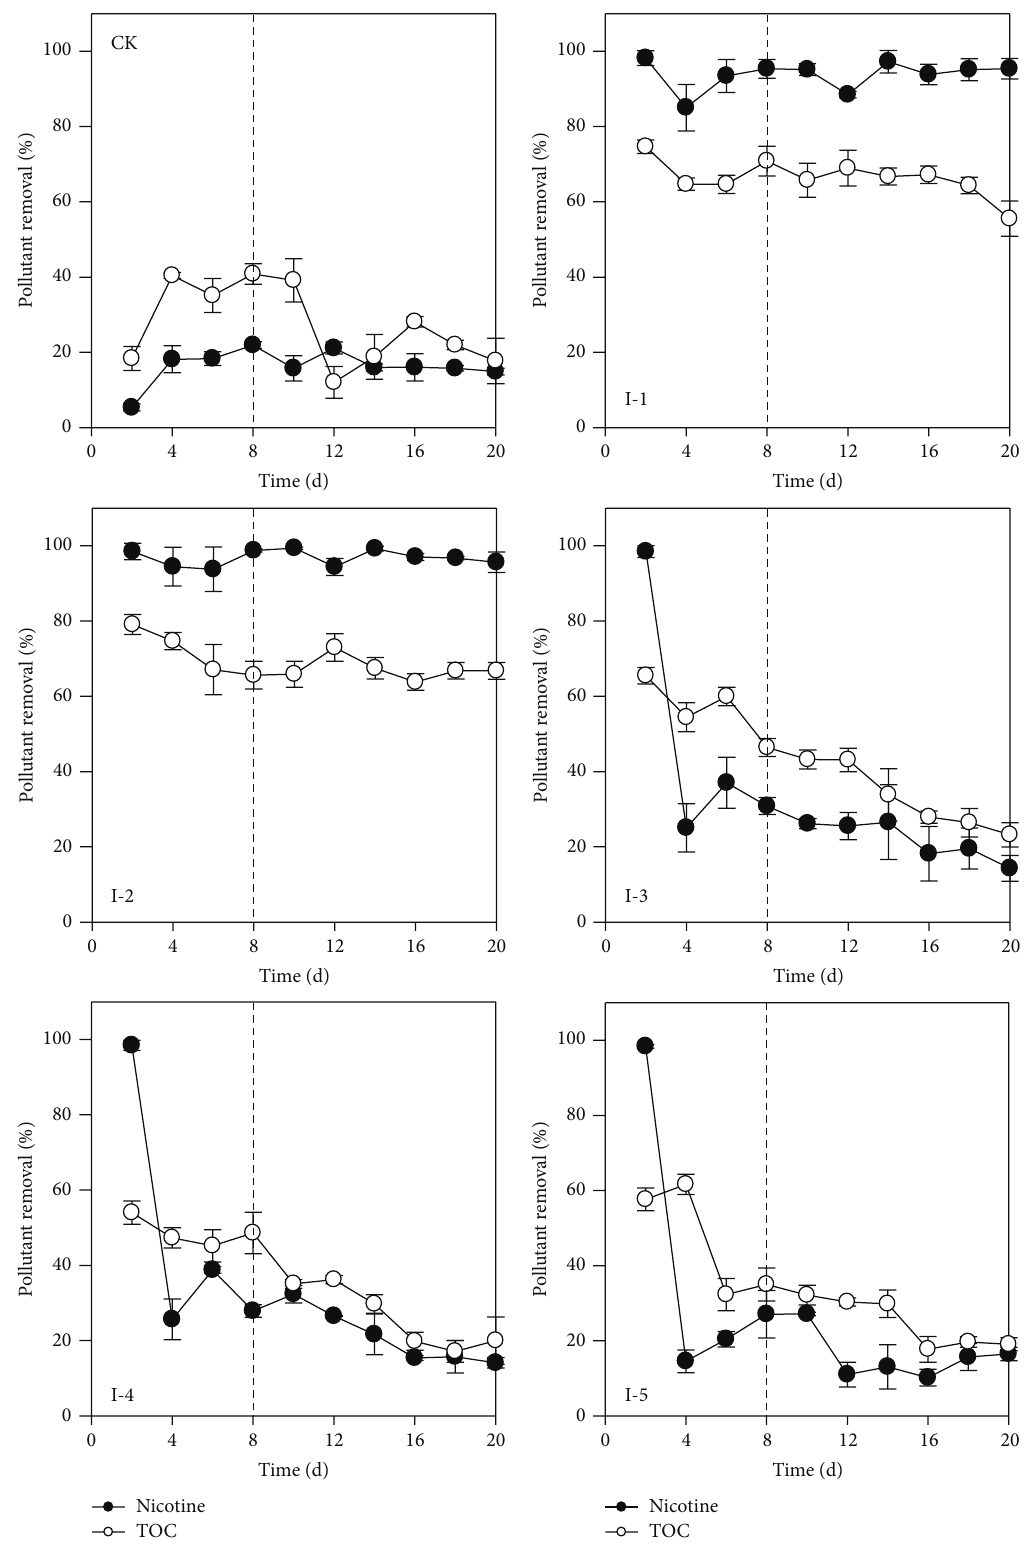
Figure 2: Effect of inoculum amount on pollutant removal in tobacco wastewater. The inoculum amount in reactor I-1 to I-5 was 0.55±0.01 , 1.10 ± 0.03 , 1.66 ± 0.04 , 2.21 ± 0.05 , and 2.76 ± 0.07 mg/g (dry weight of strain HF-1/dry weight of activated sludge), respectively. CK: noninoculated